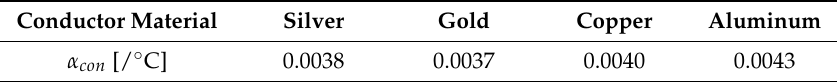
Table 2. Conductor temperature coefficient for various